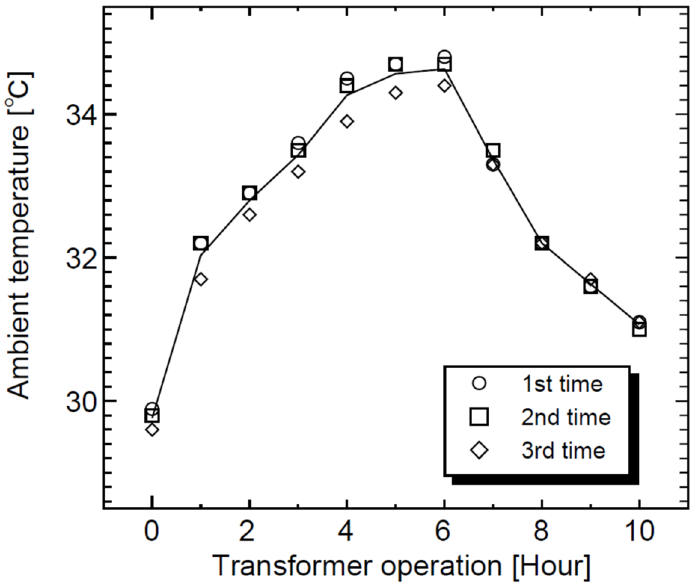
Figure 11. The ambient temperature during transformer operation.